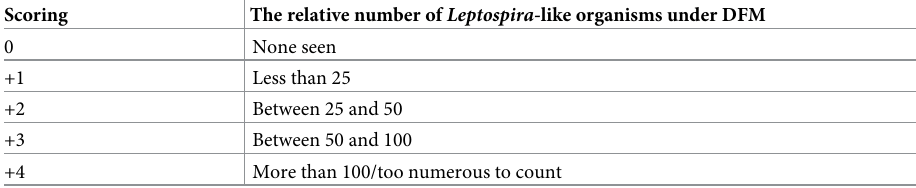
Table 1. The scoring system used in this study to evaluate cultures. Scoring The relative number of Leptospira -like organisms under